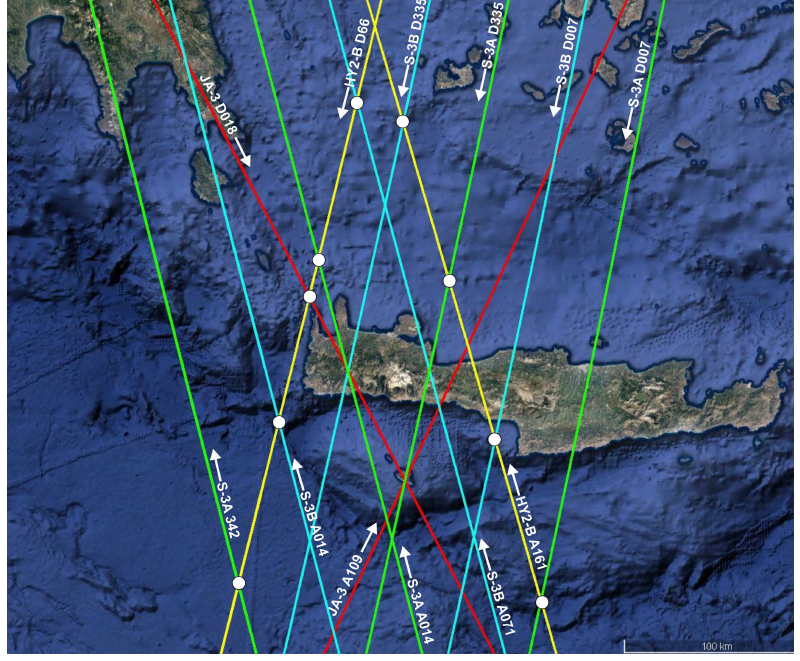
Figure 9. Distribution of HY-2B crossover points with Sentinel-3A/B and